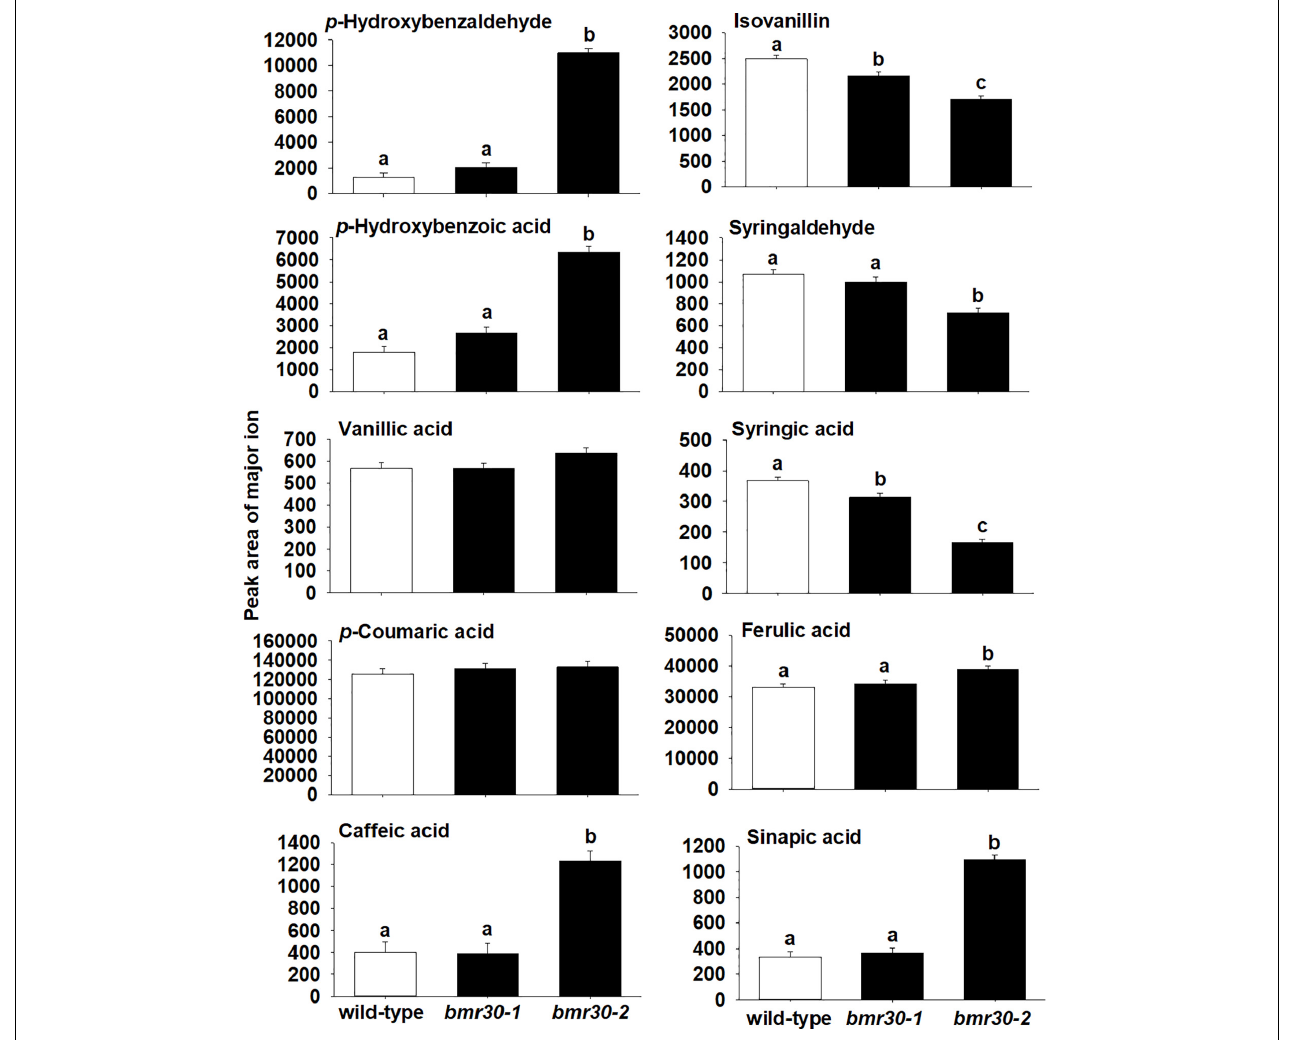
FIGURE 8 | Relative abundance of wall-bound phenolic compounds in stover from wild-type, bmr30-1 , and bmr30-2 plants. Phenolic compounds were analyzed via GC–MS. Values presented are least square means; error bars represent standard error. Samples with different letters for wall-bound fractions are statistically different from one another at α ≤ 0.05 using Tukey’s HSD